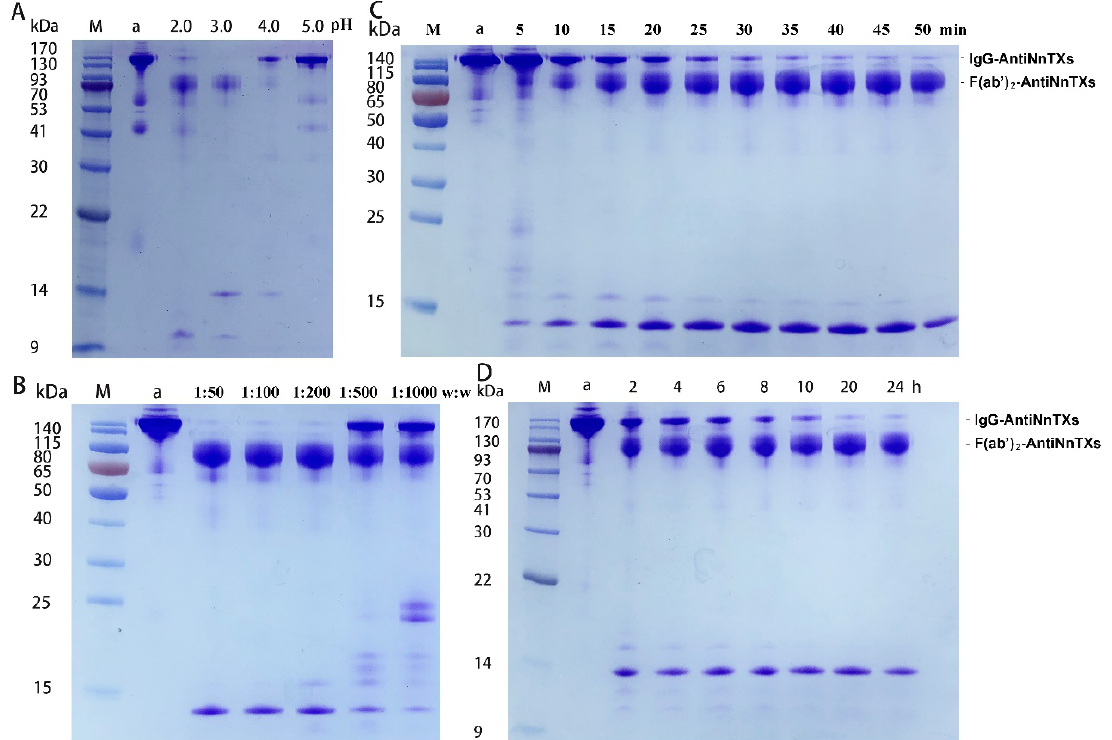
Figure 3. SDS-PAGE analysis of the optimal condition screen for the pepsin digestion of IgG-AntiNnTXs. ( A ) The effect of pH on the pepsin digestion of IgG-AntiNnTXs at 37 °C. M: protein marker; a: IgG-AntiNnTXs; 2.0: pH = 2.0; 3.0: pH = 3.0;